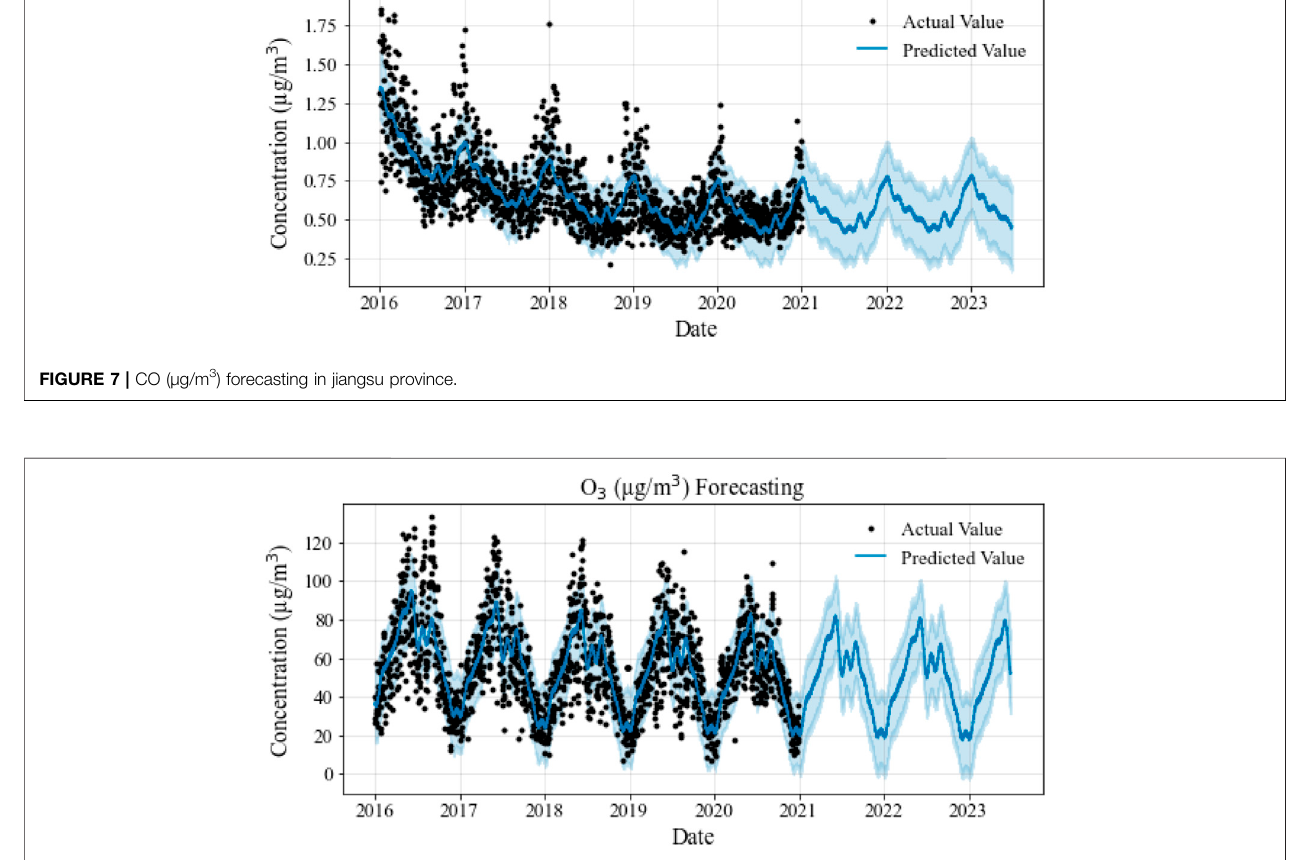
FIGURE 8 | O 3 (µg/m 3 ) forecasting in jiangsu